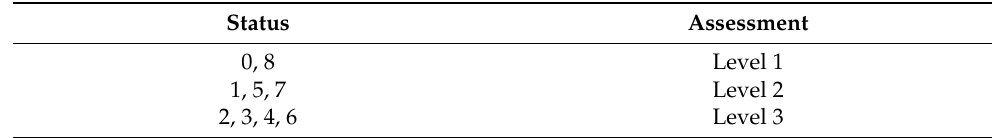
Table 4. Assessment using the ‘navigational status’ criterion [own